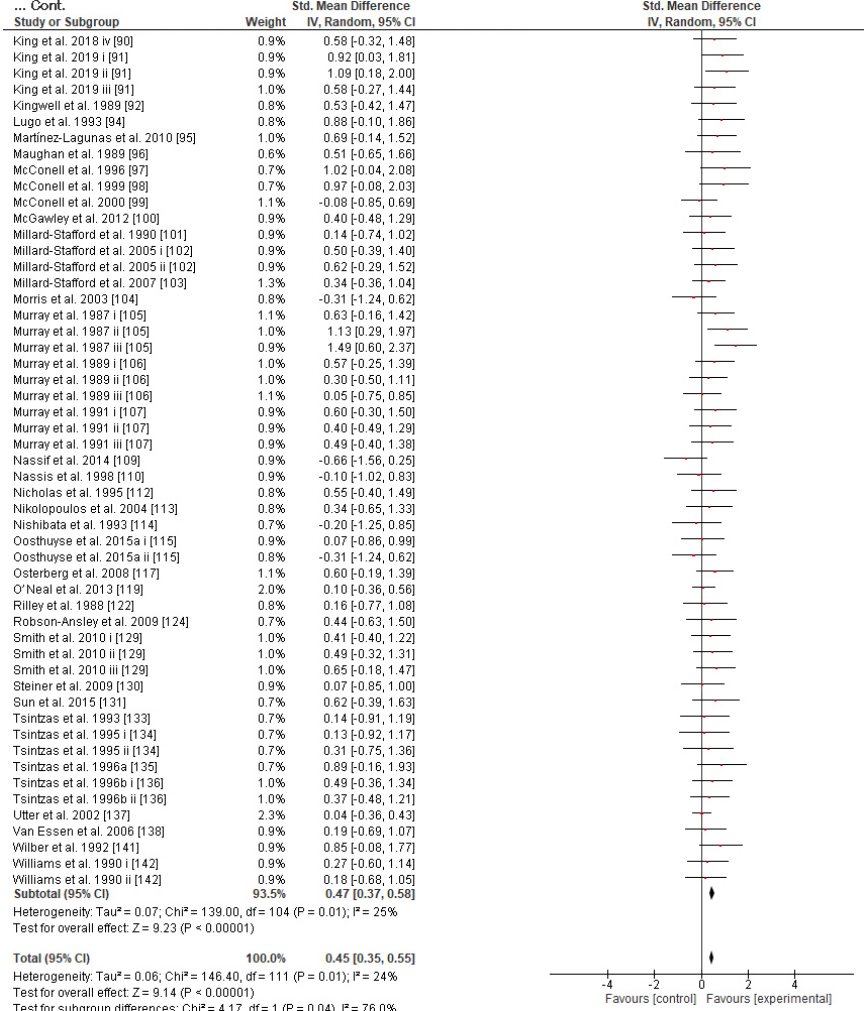
Figure 8. Forest plot shows the effects (red square symbol) of experimental carbohydrate supple ‐ mentation as compared to a control on exercise outcome for 112 interventions [48–52,54–75,77,79– 91,93–106,108,109,111–114,116–118,121,123,128–138,140,141]. Subgroup analyses show the results with regards to supplementation in two carbohydrate administration time groups (prior to or at the beginning of exercise, during exercise). The black diamond symbol at the subgroups and at the bot ‐ tom of the figure represents the standardized mean difference with the 95% confidence intervals for all interventions following random effects meta ‐ analyses. Studies or trials that provided insufficient data for subgroup classification were not included. Abbreviations: CHO, carbohydrate; CI, confi ‐ dence interval; IV, inverse variance; SD, standard deviation; Std, standardized; i–vi denote different intervention arms (trials) within the same study.